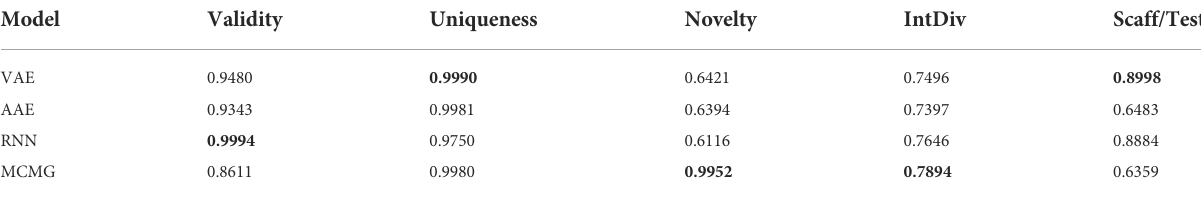
TABLE 1 Performance of each model without transfer learning.